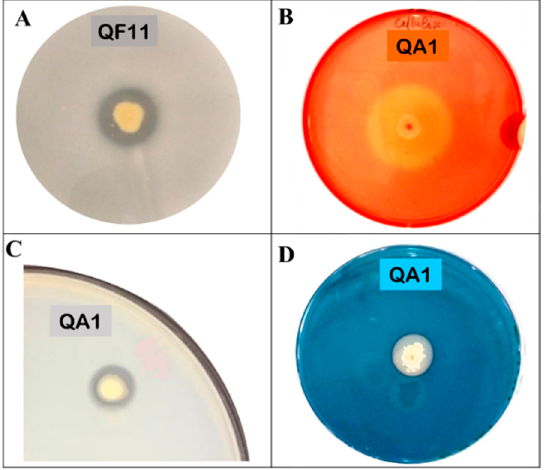
Figure 3. Illustration of tests performed on plates for the assessment of PGP (plant growth promoting) traits of selected PSB. ( A ) Phosphate solubilization, ( B ) cellulase production, ( C ) protease production, ( D ) siderophores production.